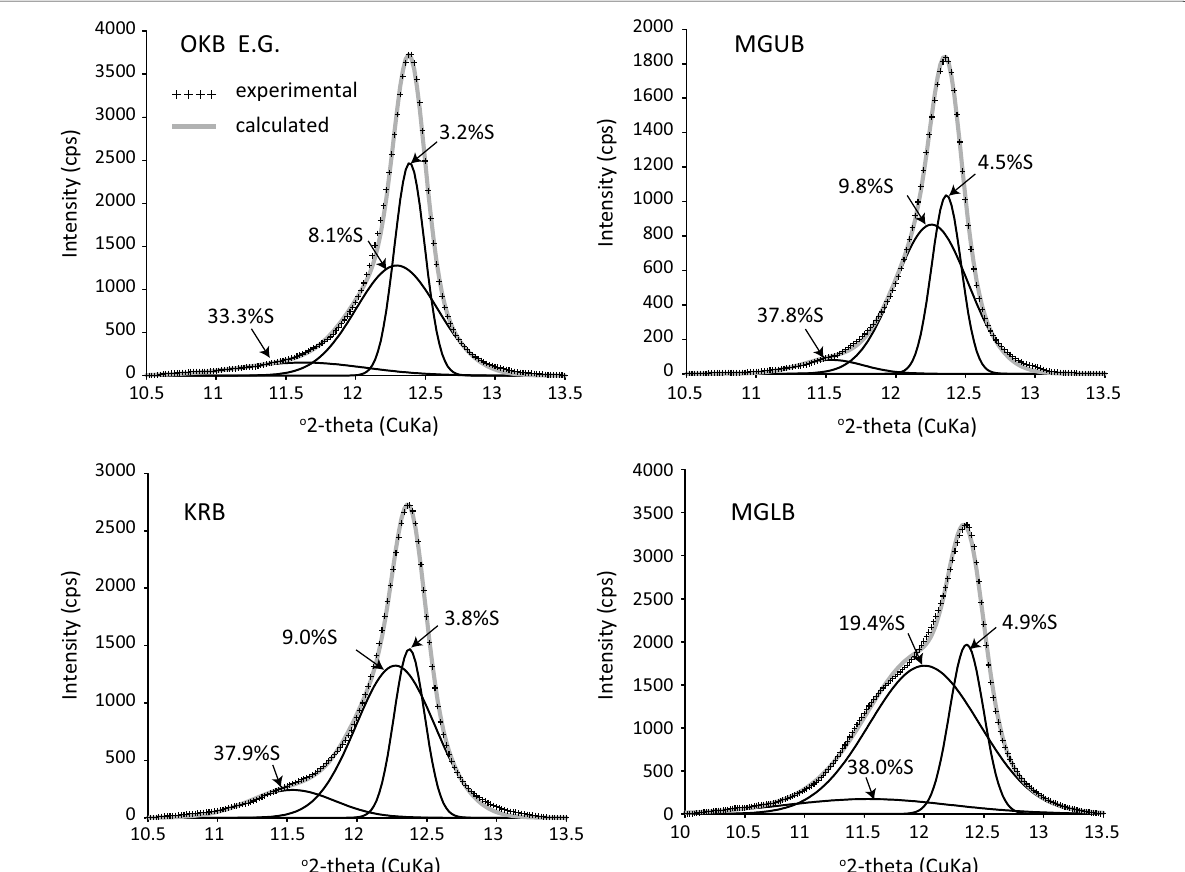
Fig. 6 Decomposition of the 7.1 Å C/S band of C/S within EG-treated samples; three peaks were used to fit the experimental profile. %S value for each decomposed peak from peak position and the working curve of Eq. (2) are also shown